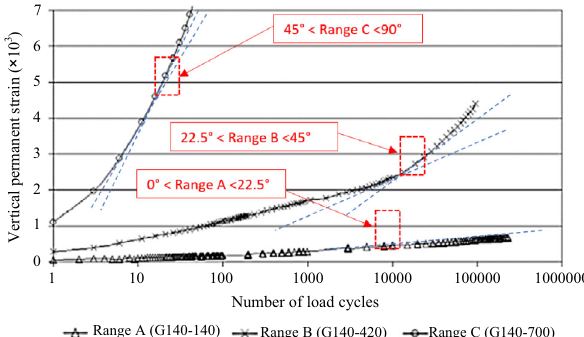
Fig. 13 RLTT results of the selected UGMs (after